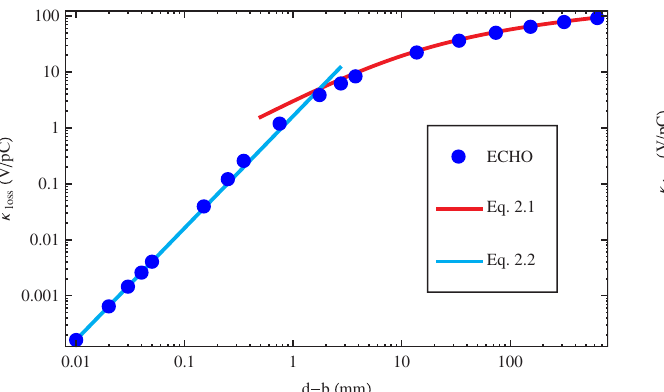
FIG. 9. (Color) For a step collimator, the dependence of the loss factor on d (cid:2) b is shown for (cid:1) ¼ 0 : 5 mm , b ¼ 6 : 25 mm , and g ¼ 10 mm . The dots represent the results of calculations using the ECHO code. The red curve is given by Eq. (2.1) and the aqua curve by (2.2).